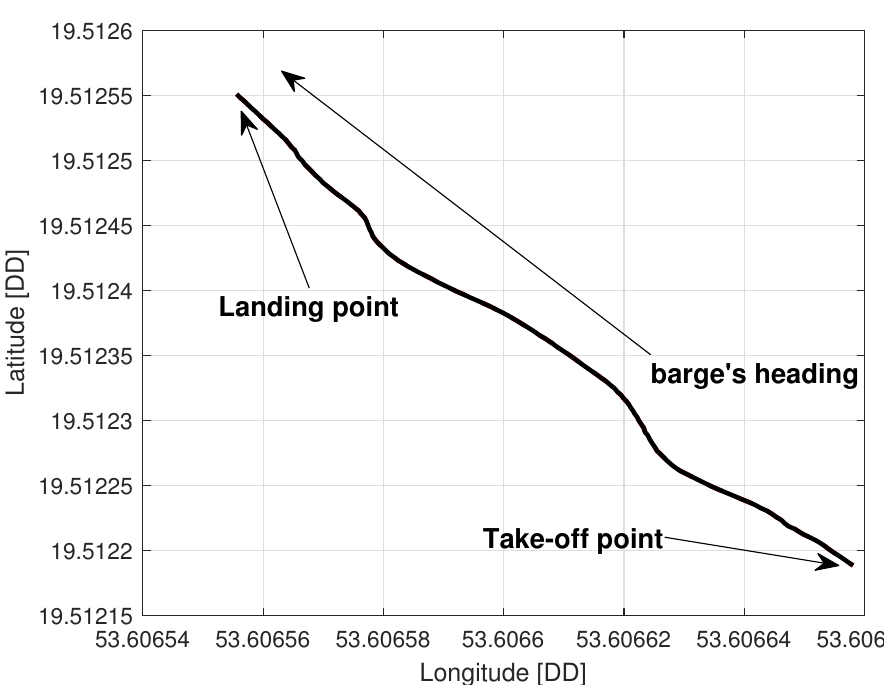
Figure 22. Multicopter path during the in-flight